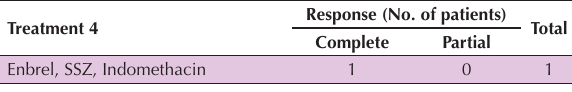
Response (No. of patients) Total Complete